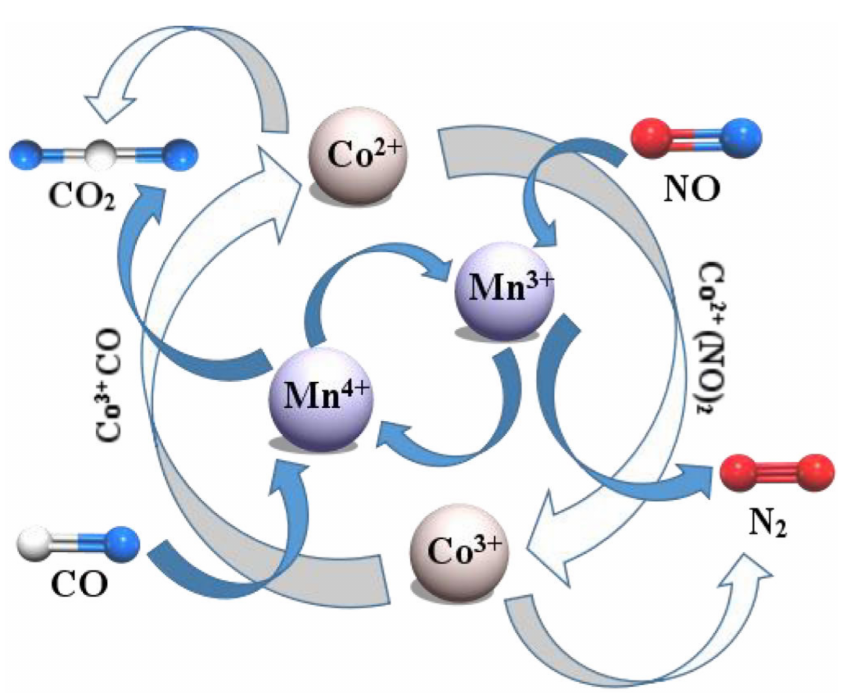
Figure 9. The catalytic process of